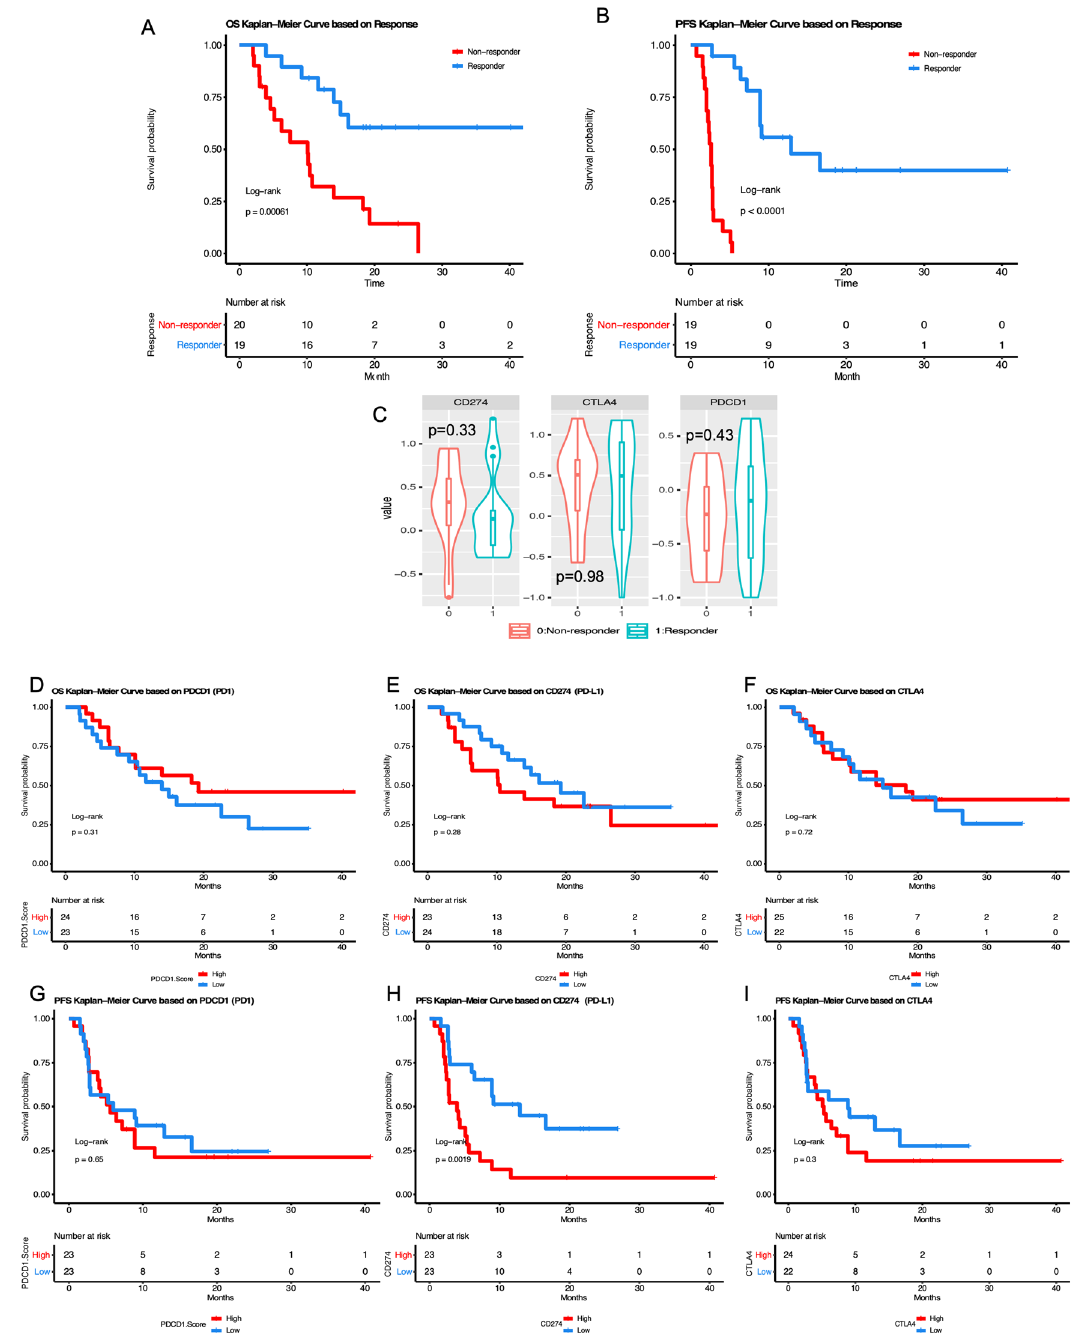
Fig. 1 Survival curve for an entire cohort based on response to immunotherapy and major know molecular biomarkers CD274 ( PD-L1) and CTLA4 expression. A Kaplan – Meier curves of overall survival (OS) based on response to immunotherapy patient received; B Kaplan – Meier curves of Progression-free survival (PFS) based on response to immunotherapy patient received; C Violin plot of CD274 (PD-L1) , CTLA4, and PDCD1 (PD1) expression between responders and non-responders; D – F Kaplan – Meier curves of OS based on PDCD1, CD274 ( PD-L1), and CTLA4 expression; G – I Kaplan – Meier curves of PFS based on PDCD1, CD274 ( PD-L1), and CTLA4 expression; For panels D – G , marker group “ High ” or “ low ” was de fi ned by median expression of each marker